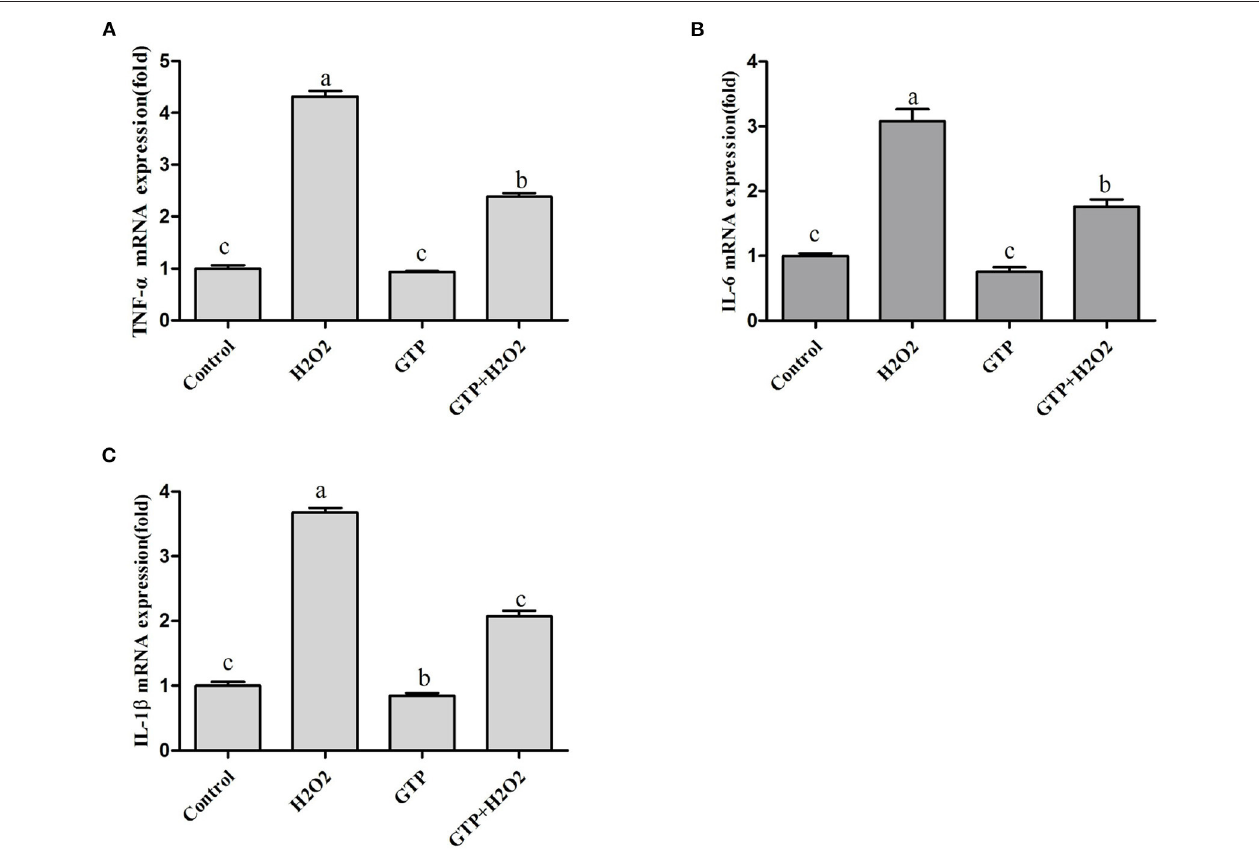
FIGURE 6 | GTP regulated the expression of TNF- α , IL-6, and IL-1 β . BMECs were treated with H 2 O 2 (500 µ M) and/or GTP (100 µ g/ml) for 12h. (A) TNF- α mRNA level, (B) IL-6 mRNA level, and (C) IL-1 β mRNA level. a,b,c, the adjacent lowercase letters indicate significant difference, the alternate lowercase letters indicate extremely significant difference, and the same lowercase letters indicate insignificant